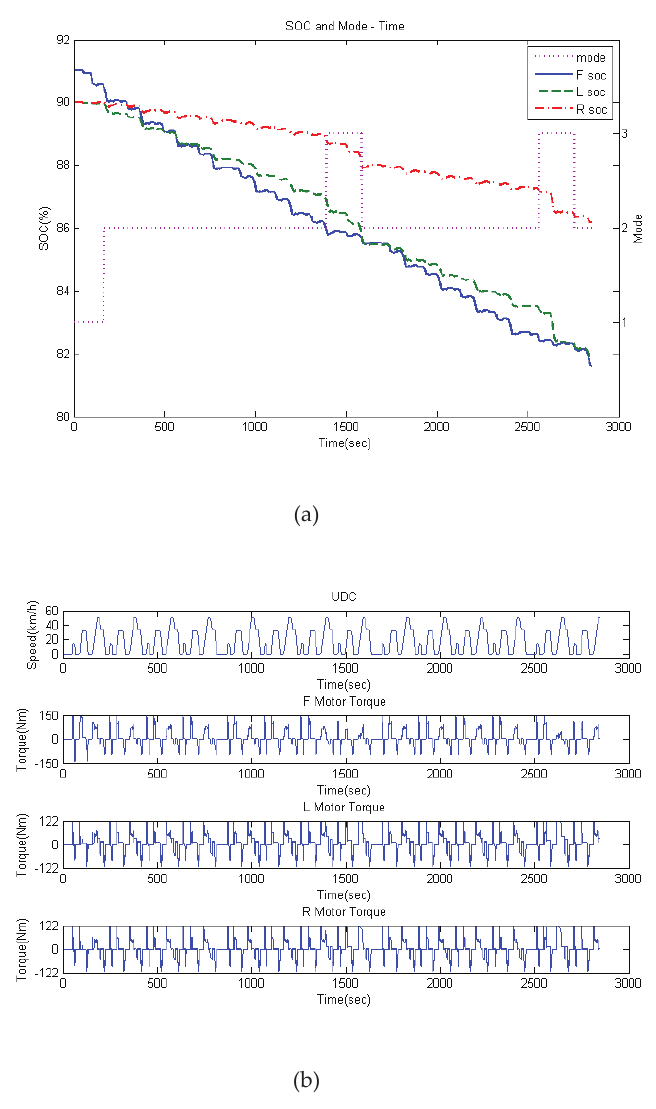
Figure 6. ( a ) The state of charge records for the three battery packs and ( b ) torque distribution from the front, rear left, and rear right traction motors during the torque and battery distribution process for the electric vehicle driving on a circular path of radius 100 m and using the urban driving cycle of the New European Driving Cycle.